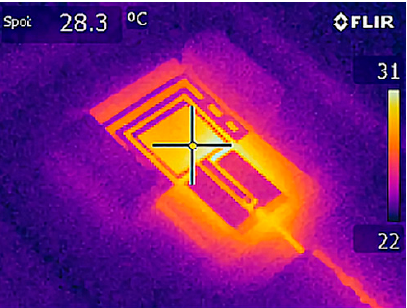
Figure 2. Numerical models of ( a ) wearable antenna, cuvettes, and erythrocyte suspension, and ( b ) flat homogeneous phantom and SAR distribution on the surface of the phantom induced from the wearable textile antenna, as incorporated in the FDTD model.